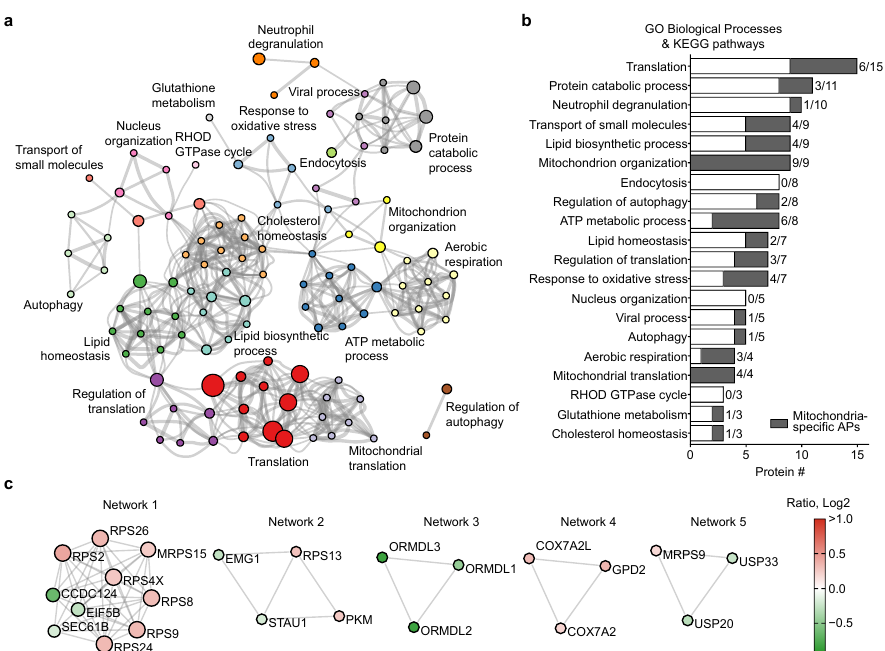
Figure 6. Functional enrichment of APs. ( a ) Clusters of biological functions and signaling pathways enriched. Protein number in each biological function/signaling pathway is proportional to the size of the node. ( b ) The number of APs in each cluster enriched. Mitochondria-localized APs are shown in gray. ( c ) Protein-protein interaction (PPI) networks enriched.